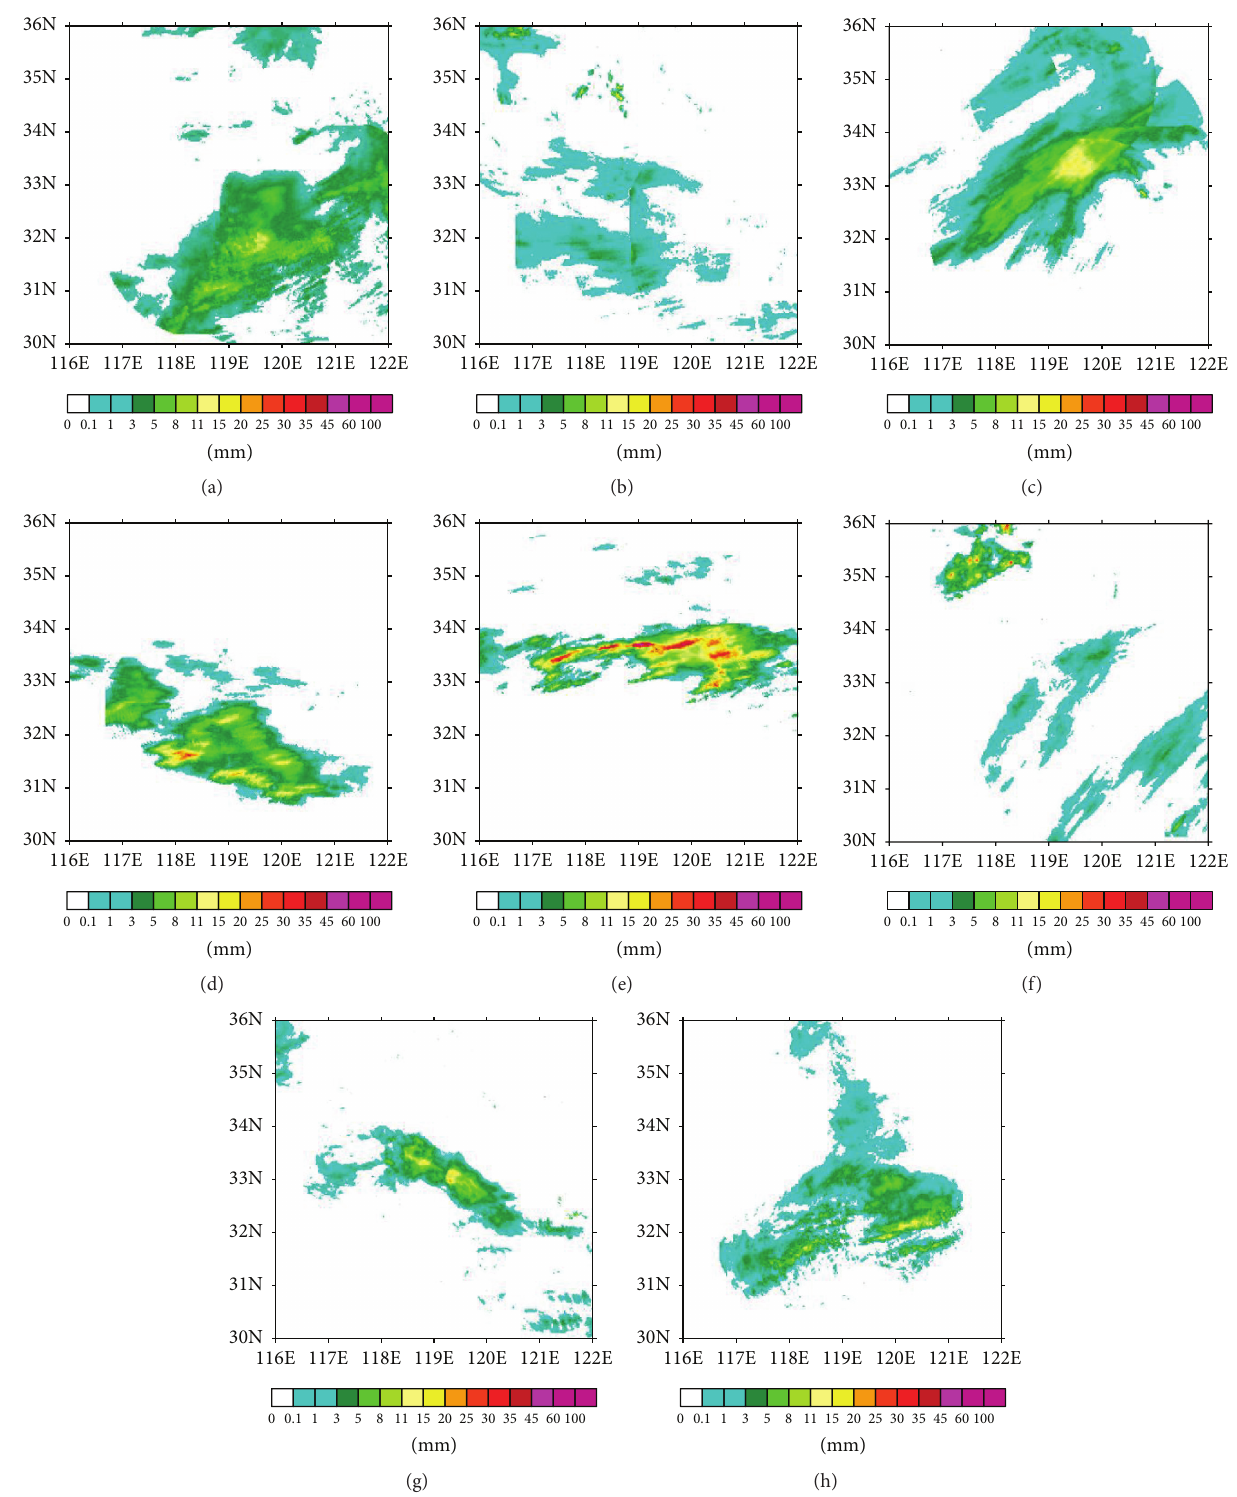
Figure 2: Precipitation images of 1 h QPE of six heavy rain events used in this study. Image at 0400 BJT on 1st of June 2014 for event 1 (a), image at 2300 BJT on 16th of June 2014 for event 2 (b), image at 0100 BJT on 13th of August 2014 for event 3 (c), image at 0900 BJT on 16th of June 2015 for event 4 (d), image at 1500 BJT on 24th of June 2015 for event 5 (e), image at 1200 BJT on 6th of July 2015 for event 6 (f), image at 0900 BJT on 11th of April 2014 for event 7 (g), and image at 2100 BJT on 17th of April 2014 for event 8